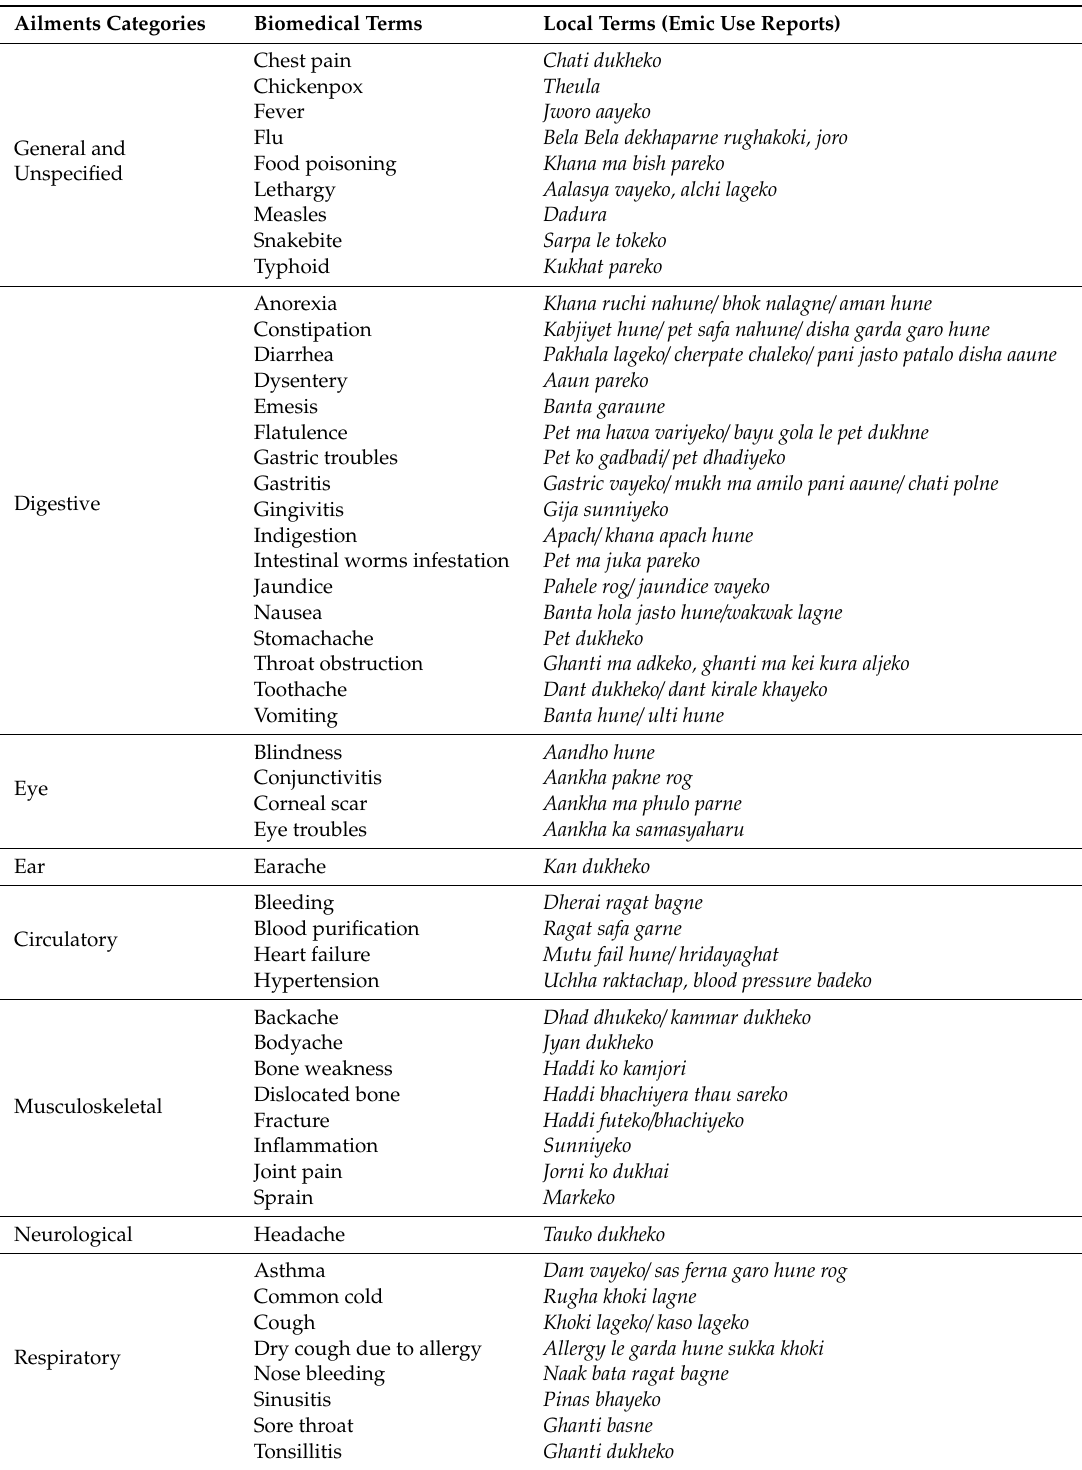
Table 3. Categories of diseases and ailments based on body system, along with their biomedical and emic use